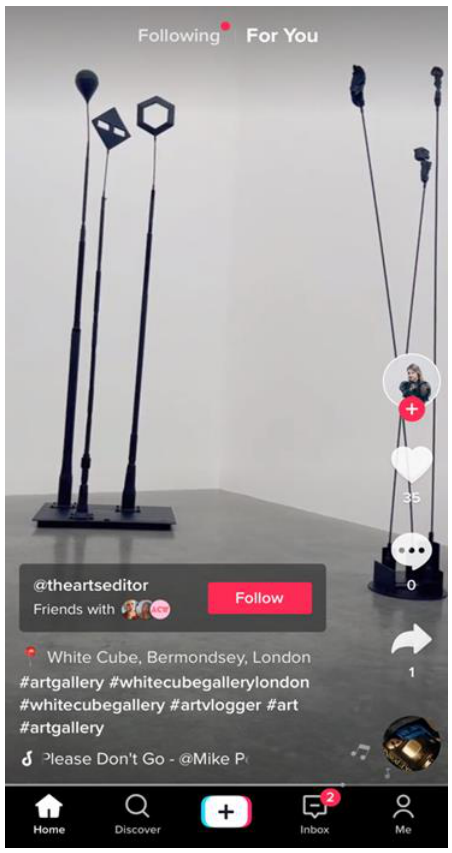
Figure 1. Main page of TikTok with Following (upper-left) and For You (upper right) feeds.